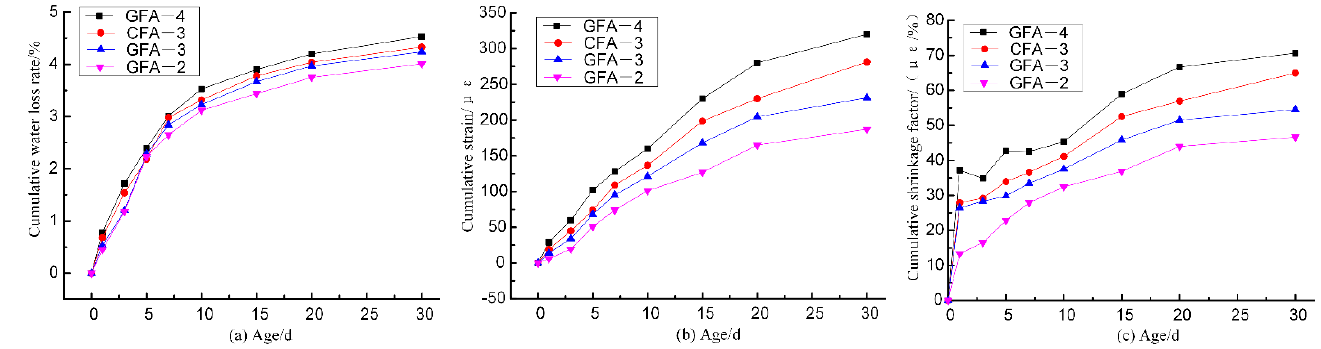
Figure 4. Dry shrinkage test change with time. ( a ) Cumulative water loss rate. ( b ) Cumulative strain. ( c ) Cumulative shrinkage